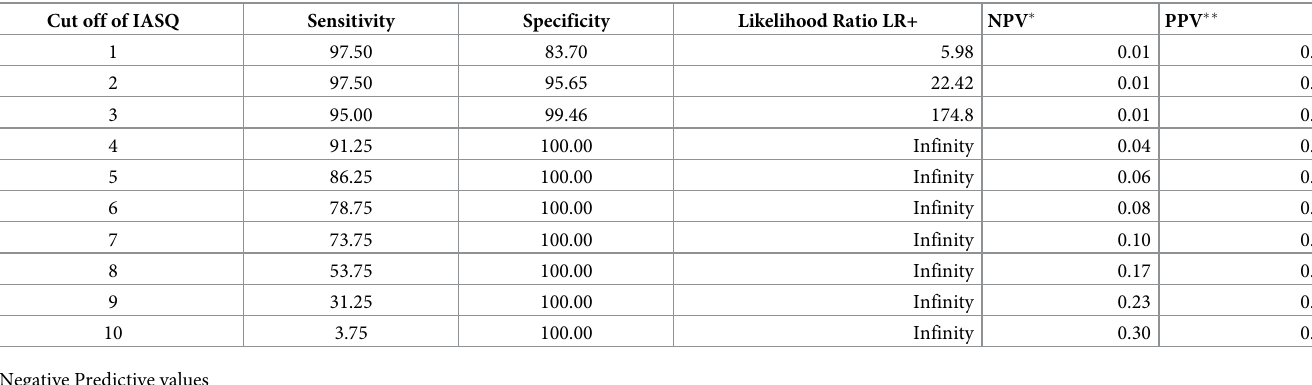
Table 4. Sensitivity and specificity of IASQ against ISAA. (n = 264).